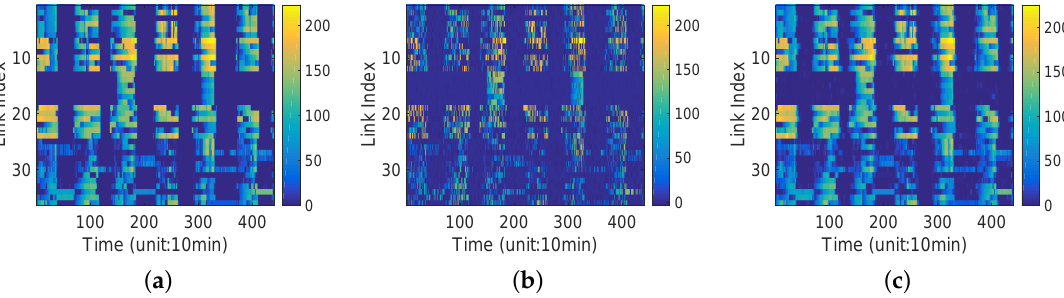
Figure 4. ( a ) Original data matrix (Avg. error = 0); ( b ) processed by standard toolbox in Matlab (Avg. error = 20.69); and ( c ) processed by LESS (Avg. error = 4.89). Heat map for the original ( a ); and recovered ( b , c ) data matrices. Larger error is introduced by standard CS than LESS does. (Sampling rate = 0.5, data from George Town